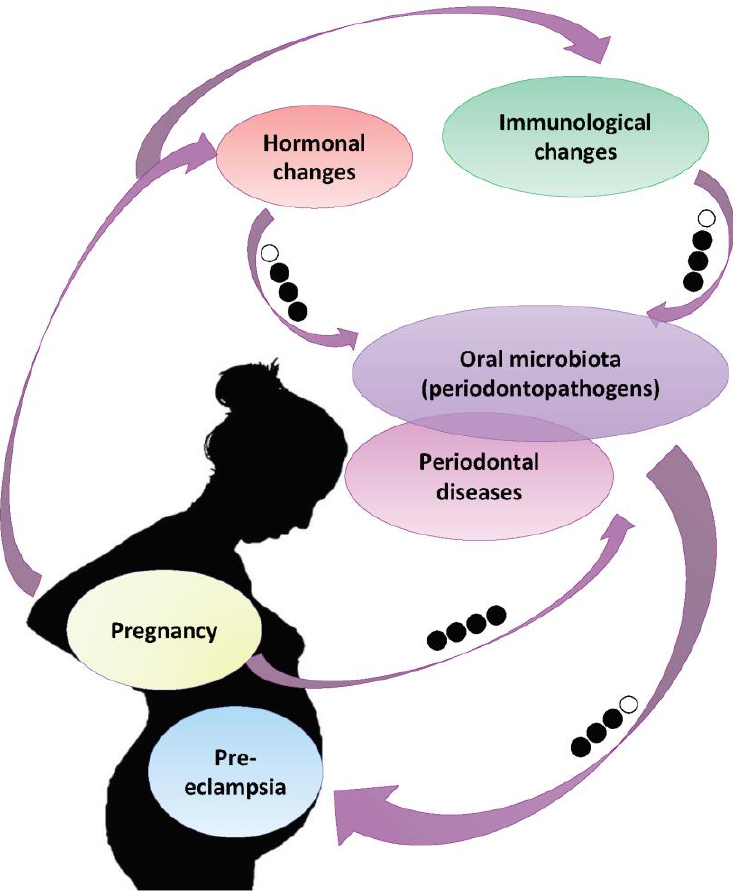
Figure 2 . Summary of the results based on the Grade process. High ( ⬤⬤⬤⬤ ) when the true effect Figure 2. Summary of the results based on the Grade process. High ( lies close to that of the estimate of the effect, moderate ( ⬤⬤⬤  ) when is likely to be close to the estimate of the effect, but there is a possibility that it is substantially different, low ( ⬤⬤  ) when may be substantially different from the estimate of the effect, and very low ( ⬤  ) when is likely to be substantially different from the estimate of effect.